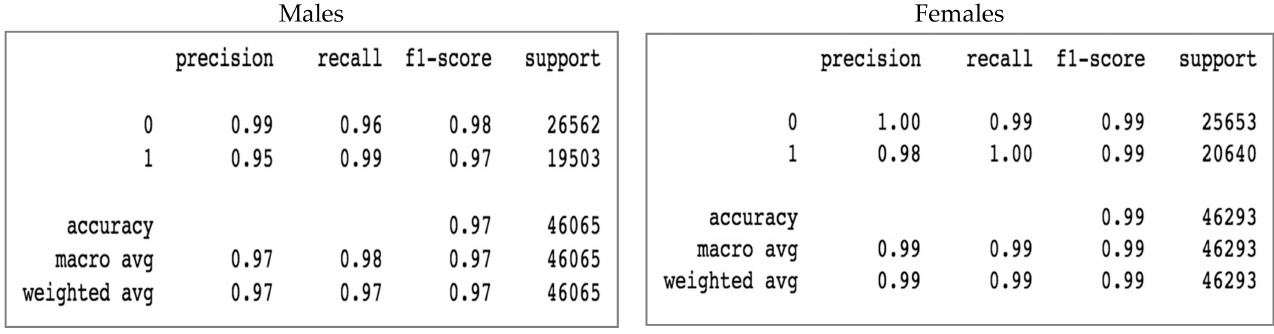
Figure 12. Classification report for VGG16’s experiment 2.